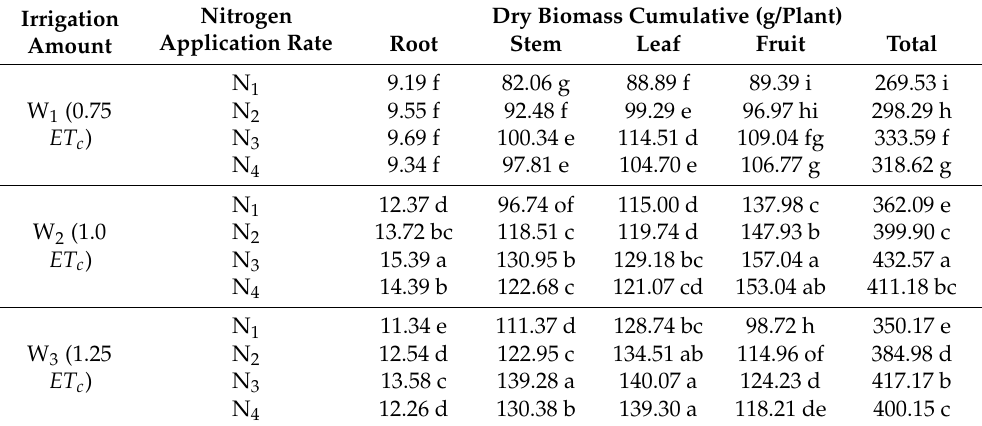
Table 3. Effects of different water and nitrogen supplies on dry matter accumulation and distribution of greenhouse tomatoes.